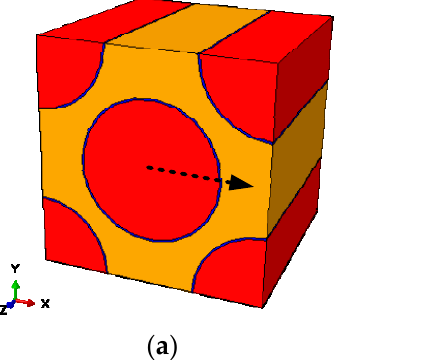
Figure 4. Fiber random distribution microscale RVE considering interface.